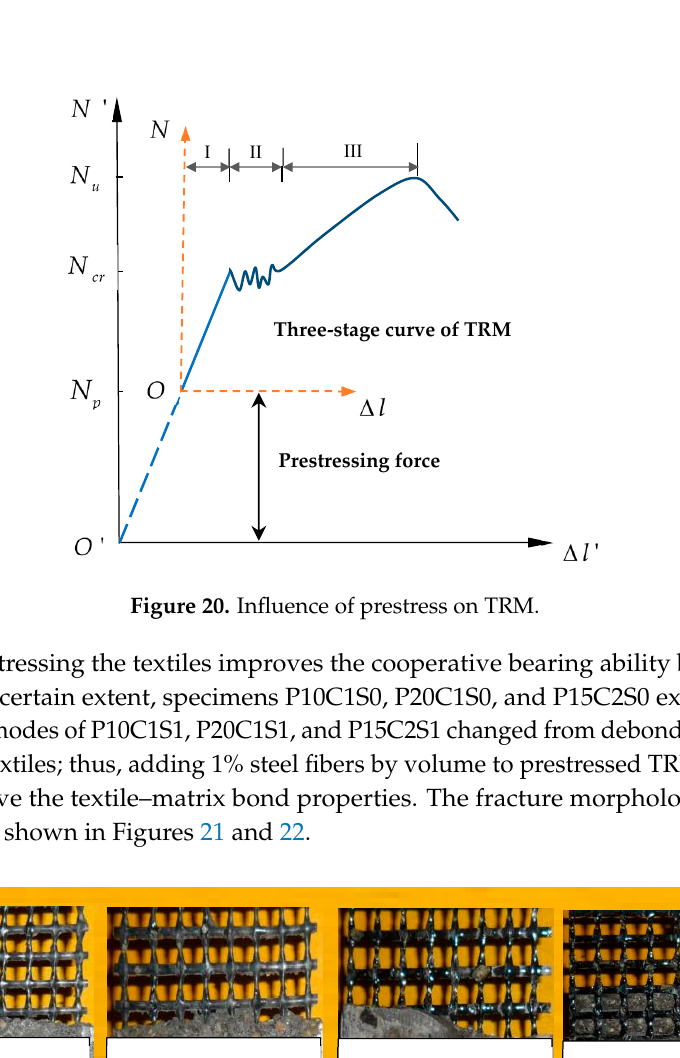
Three ‐ stage curve of TRM